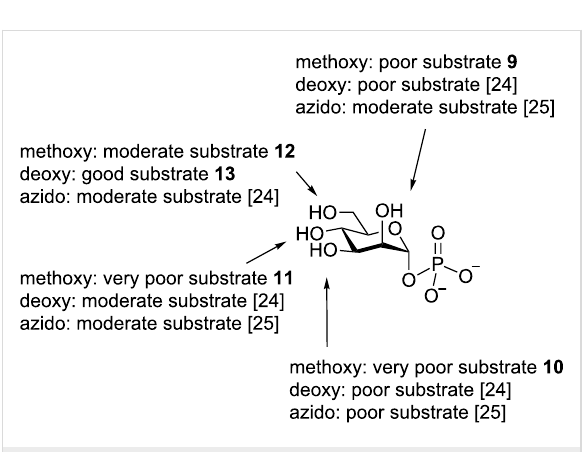
Figure 6: Summary of the substrate specificity of GDP-ManPP. Data from previous studies on the enzyme are also included as indicated [24,25].